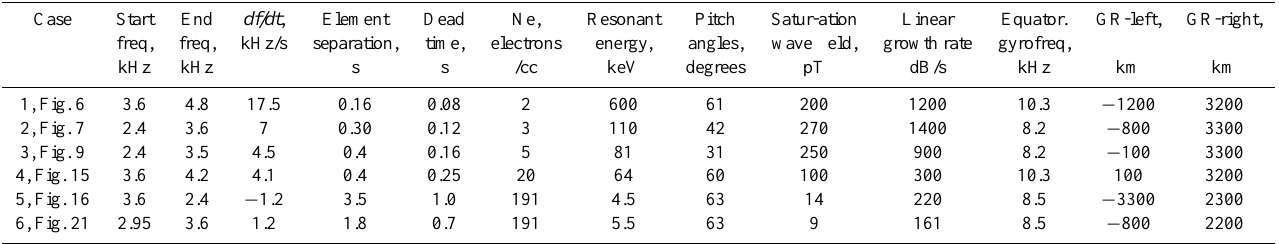
Table 1. Summary of input and output data for the six simulation runs. The dead time, the time between the end of one chorus element and the start of the next, is the duration of the quiet band plus the delay before the next elements starts. GR-left and GR-right are the approximate boundaries of the generation region relative to the